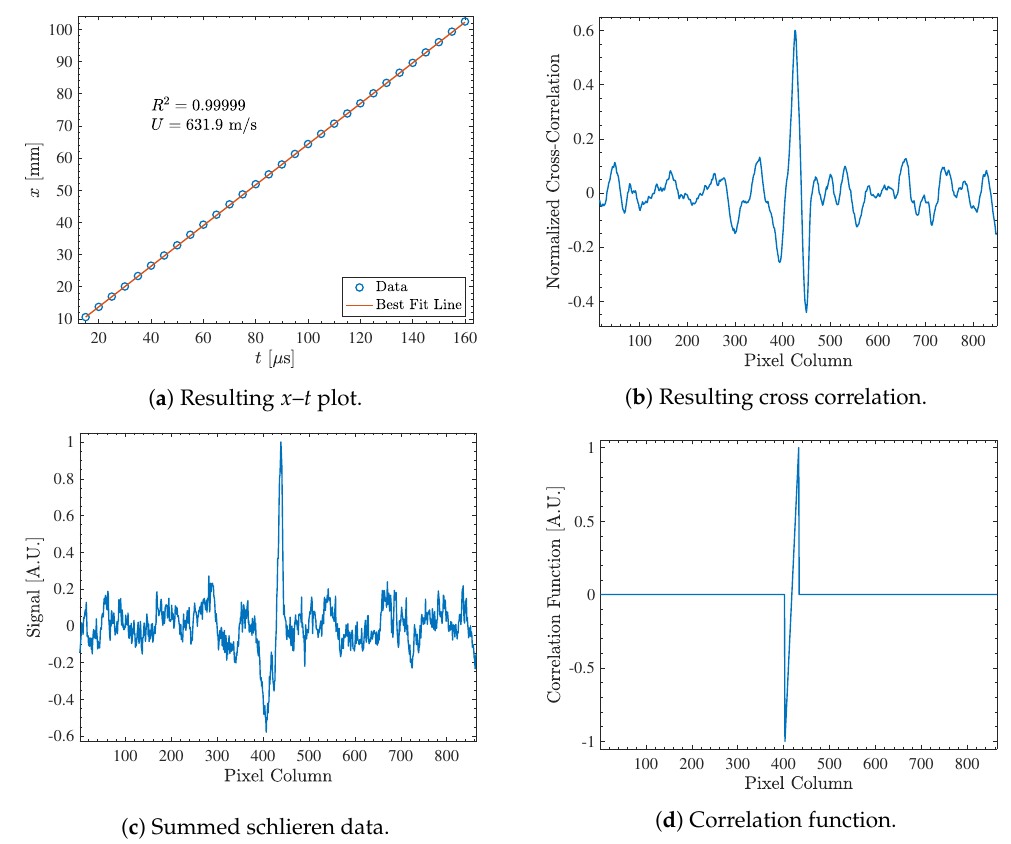
Figure 11. Representative cross correlation results for the hot gas kernel in Figure